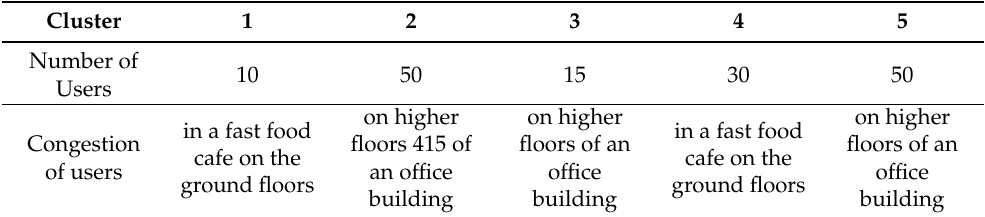
Table 3. Simulation parameters.